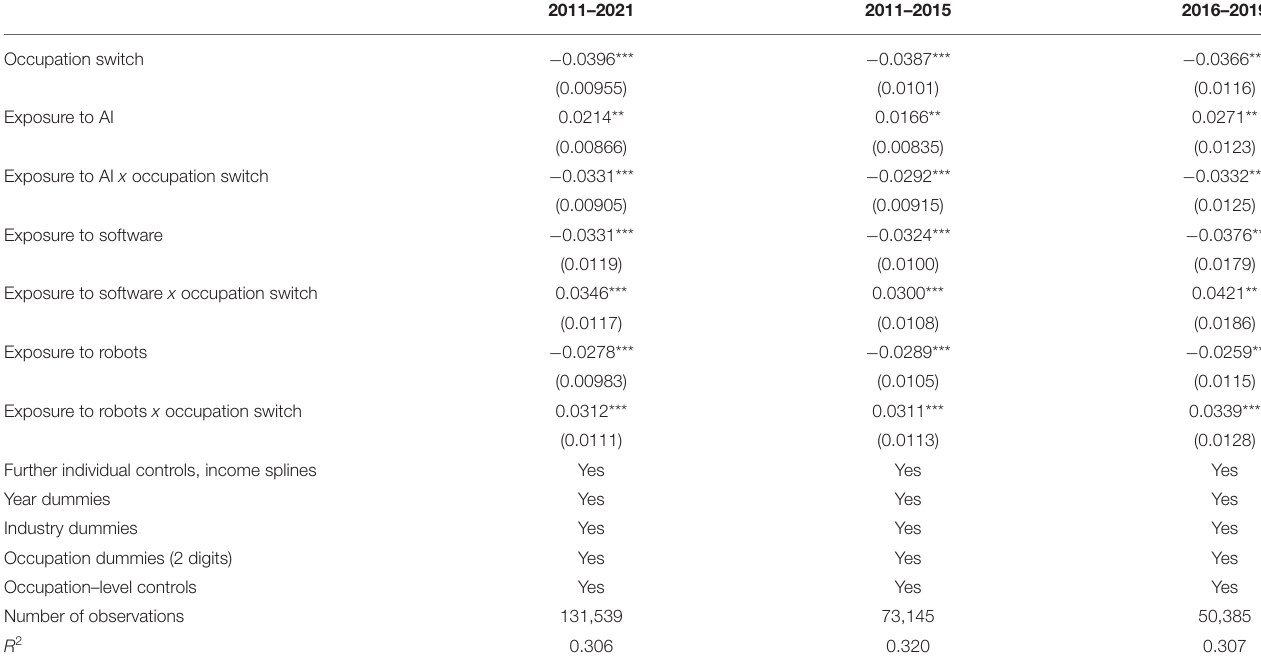
TABLE 3 | Technology exposure and annual wage growth in different